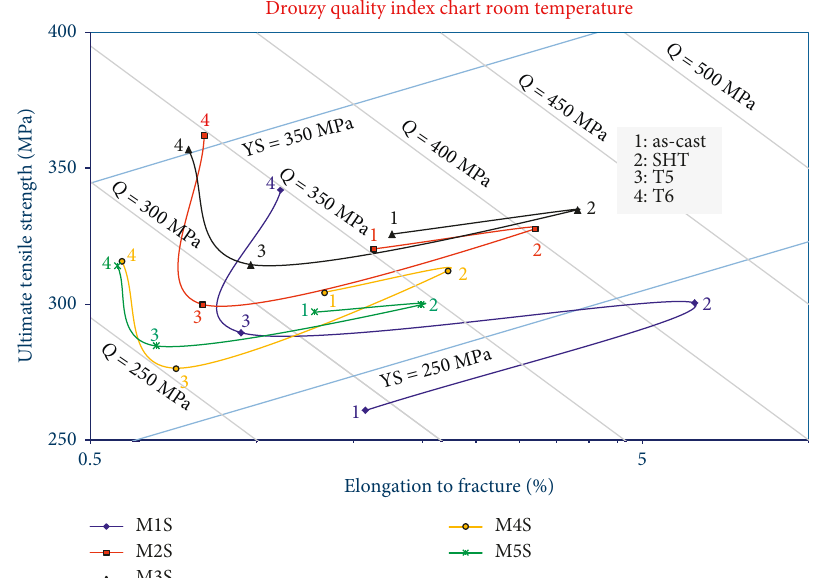
Figure 4: Drouzy quality chart representing the relation between the UTS and the percent elongation to fracture values of the alloys studied in the as-cast, SHT, and T5- and T6-treated conditions obtained at ambient